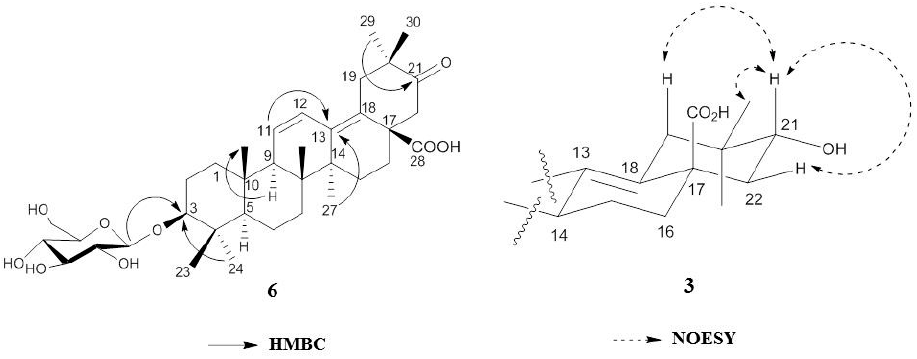
Figure 2. HMBC correlation of compound 6 and NOESY correlation of compound 3 .